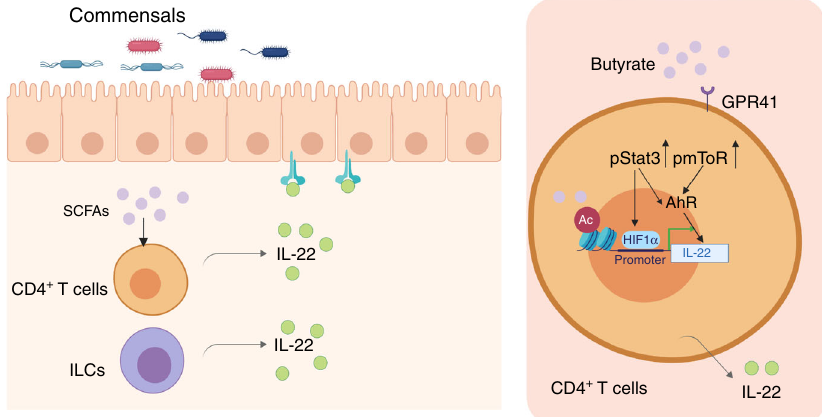
Fig. 10 SCFAs induction of IL-22 in CD4 + T cells and ILCs. Gut microbiota-derived SCFAs promote IL-22 production in CD4 + T cells and ILCs. Mechanically, butyrate promotes IL-22 production through GPR41 and HDAC inhibition. Furthermore, butyrate upregulates HIF1 α and AhR, which is differentially regulated by mTOR and Stat3. HIF1 α directly binds to the Il22 promoter, and butyrate increases HIF1 α binding to the Il22 promoter